Question: Name the type of graph shown.
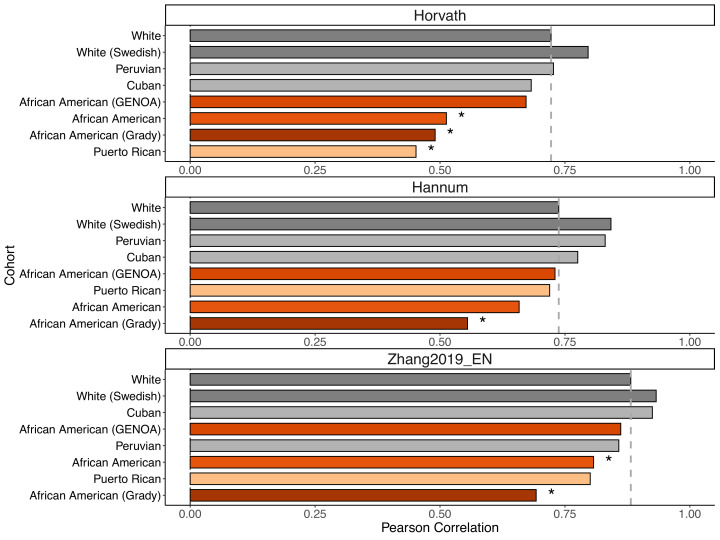
Answer: bar